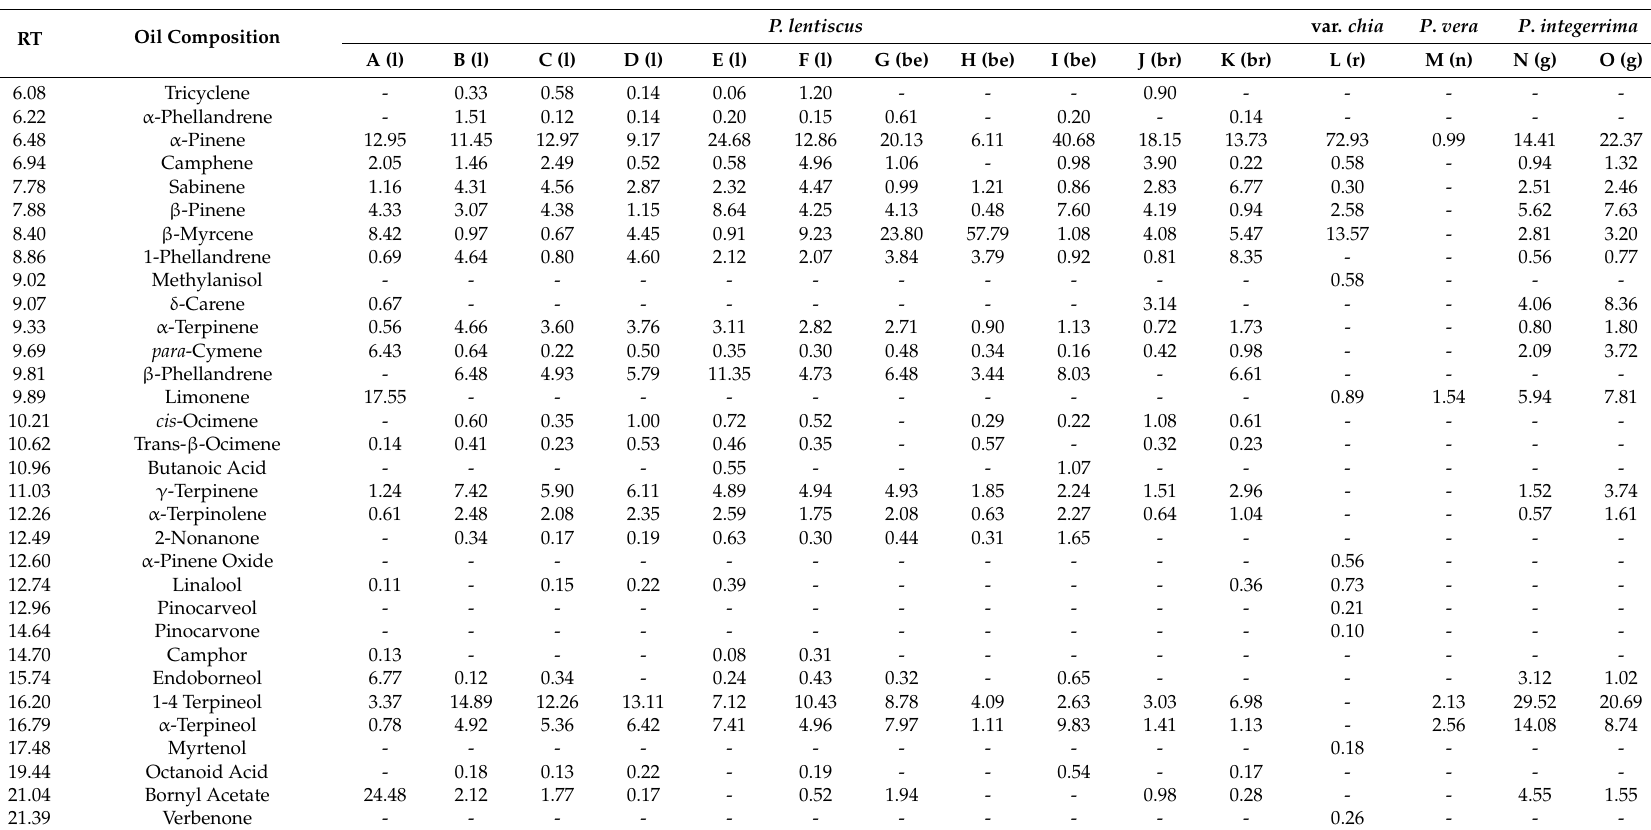
Table 1. Oil composition of P . lentiscus , P . lentiscus var. chia, P . vera , and P . integerrima